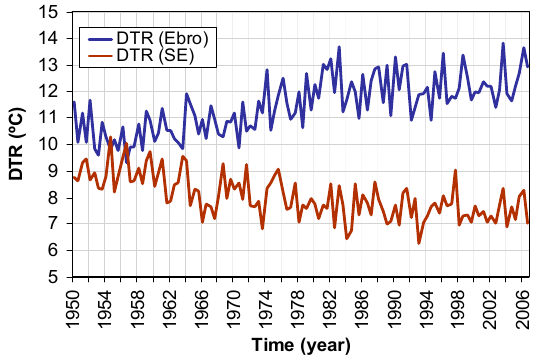
Figure 11. Time series of DTR at Ebro (blue) and SE close to the coast (brown).